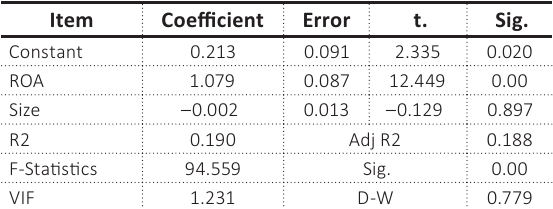
Table 7. OLS findings for the study models